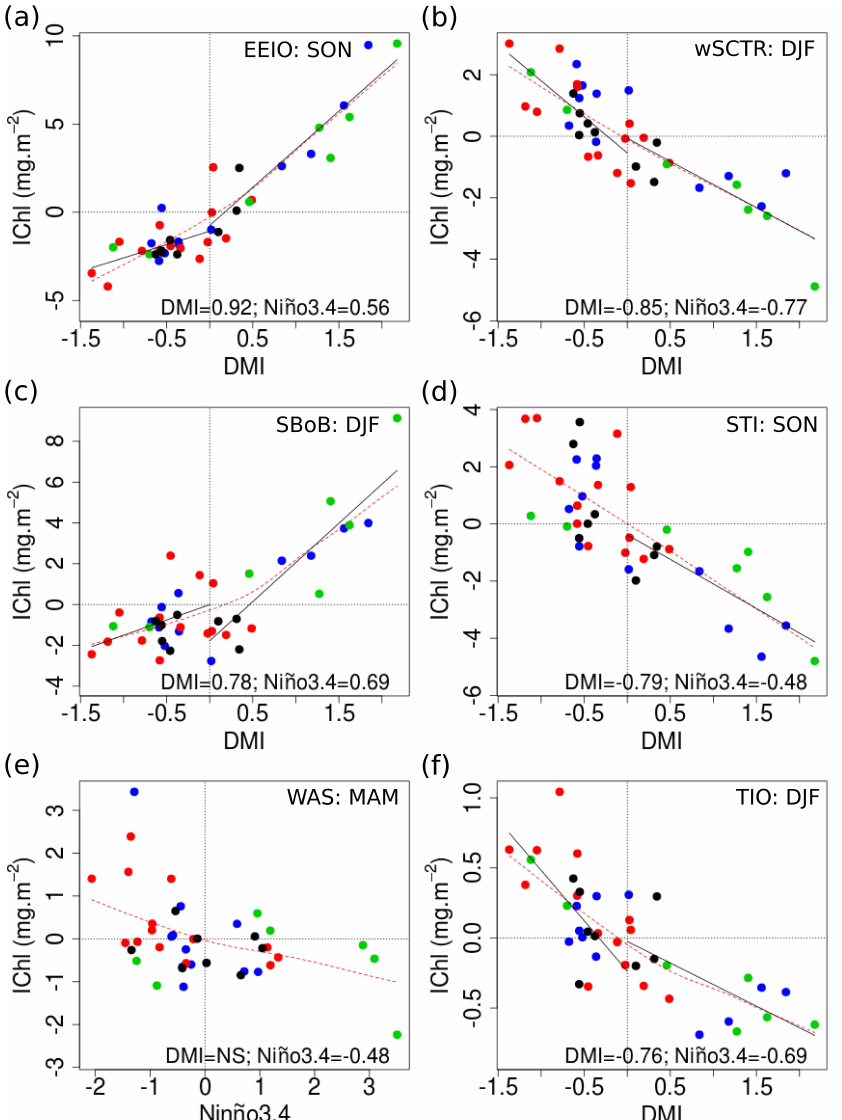
Fig. 10. Scatterplots showing the magnitude of I Chl anomalies against climate mode indices across all years (1961–2001). I Chl anomalies are averaged over the regions of interest and over the same seasons as selected in Tables 1 and 2, namely: (a) EEIO in SON, (b) wSCTR in DJF, (c) SBoB in DJF, (d) STI in SON, (e) WAS in MAM and (f) TIO in DJF. Climate mode events as identified by Meyers et al. (2007) are indicated by colour: pure IOD events are blue, pure ENSO events red, co-occurring events green and non-event years black. Significant correlation coefficients ( p < 0 . 05) between I Chl and climate indices are provided on the plot or indicated as NS (not significant; p ≥ 0 . 05). Solid black lines represent the slopes of significant regressions ( p < 0 . 05), fit separately to index values > 0 and < 0. Dashed red lines illustrate loess smooth curves fit by least squares (allowing a non-linear best